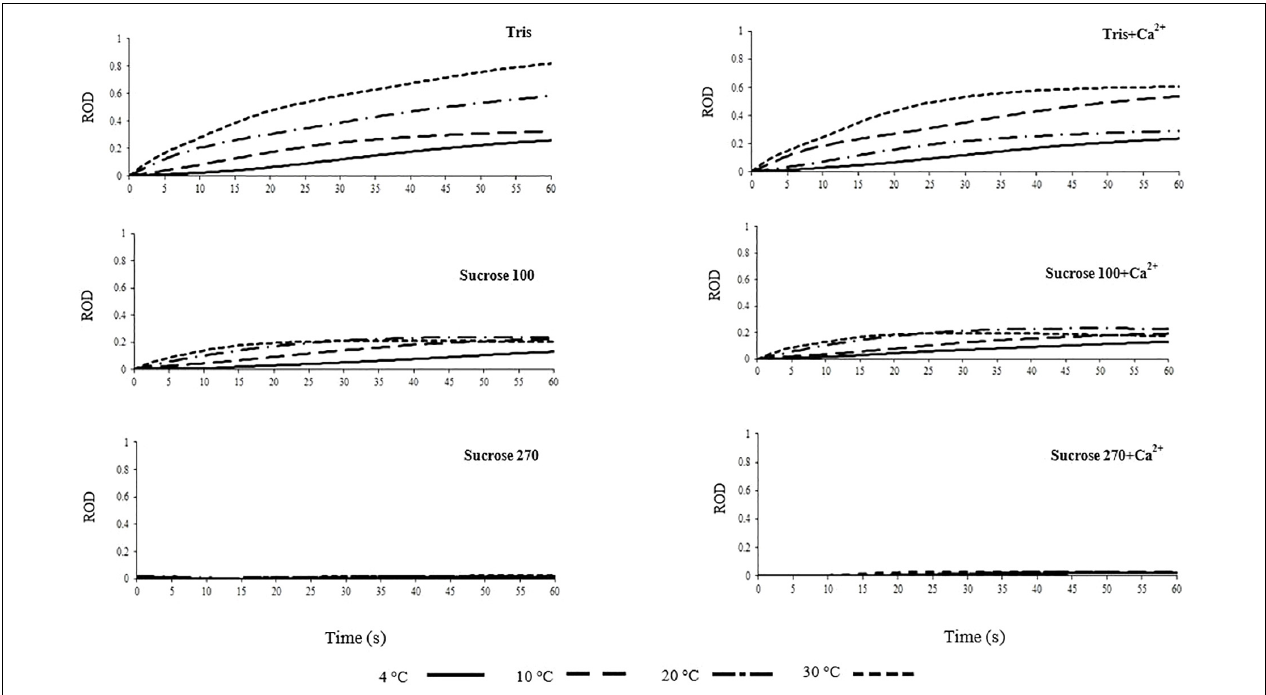
FIGURE 4 | Relative optical density (ROD) of L. lota spermatozoa in relation to time post-activation (up to 60 s) at 4, 10, 20, and 30 ◦ C in Tris, Tris + Ca 2 + , Suc 100, Suc 100 + Ca 2 + , Suc 270, and Suc 270 + Ca 2 +